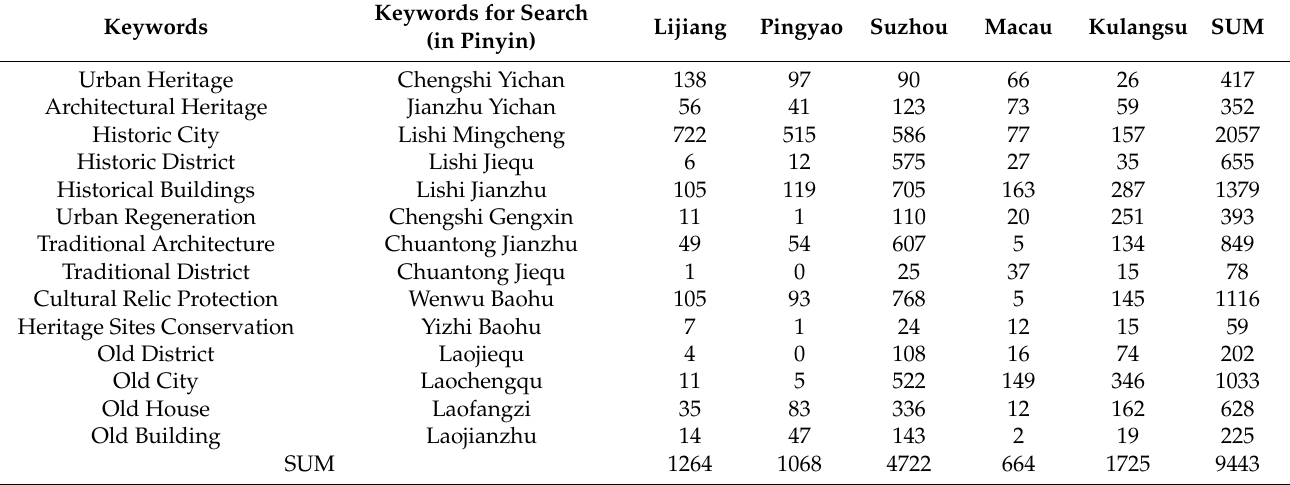
Table 1. The unprocessed database with a time restriction from 1 January 2020 to 31 December 2020 from